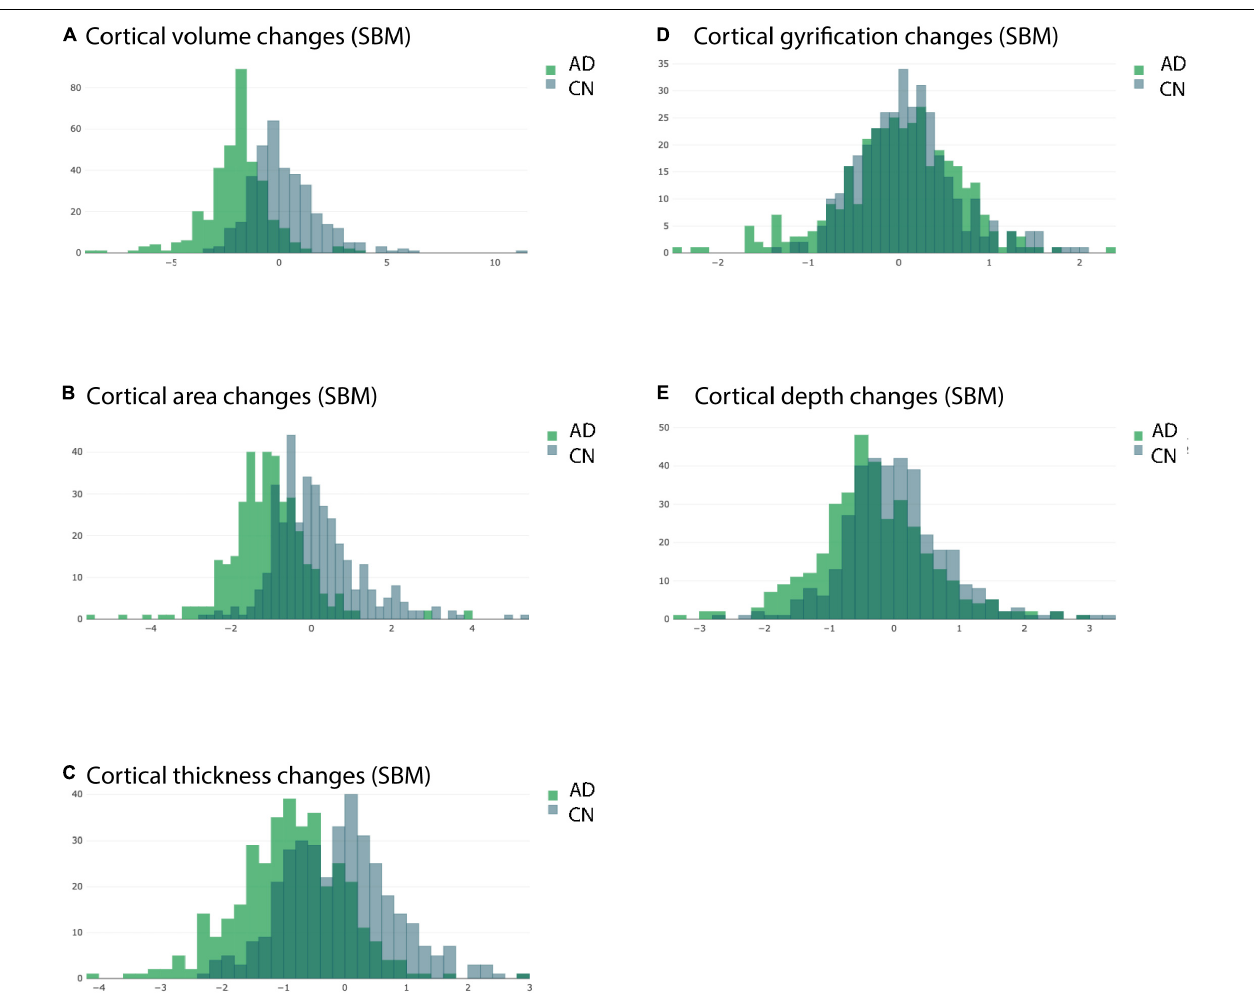
FIGURE 6 | Overlaid histograms of the AD and CN group averaged APC values. Each histogram shows the group averaged APC values from longitudinal SBM of all ROIs (including those with significant and non-significant differences) from the respective group. (A) Changes in cortical volume measured by longitudinal SBM. (B) Changes in cortical area measured by longitudinal SBM. (C) Changes in cortical thickness measured by longitudinal SBM. (D) Changes in cortical gyrification measured by longitudinal SBM. (E) Changes in cortical depth measured by longitudinal